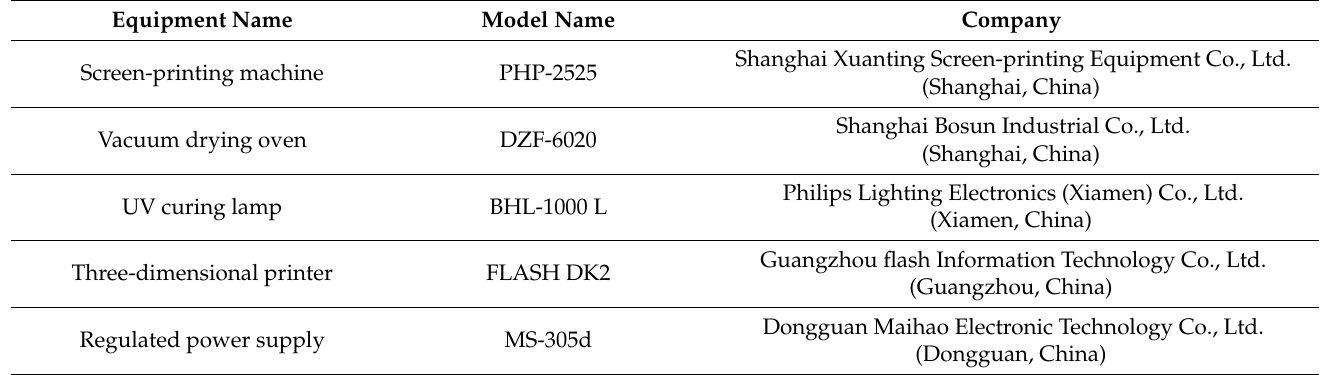
Table 2. Equipment and models, and the companies that made them, used in the